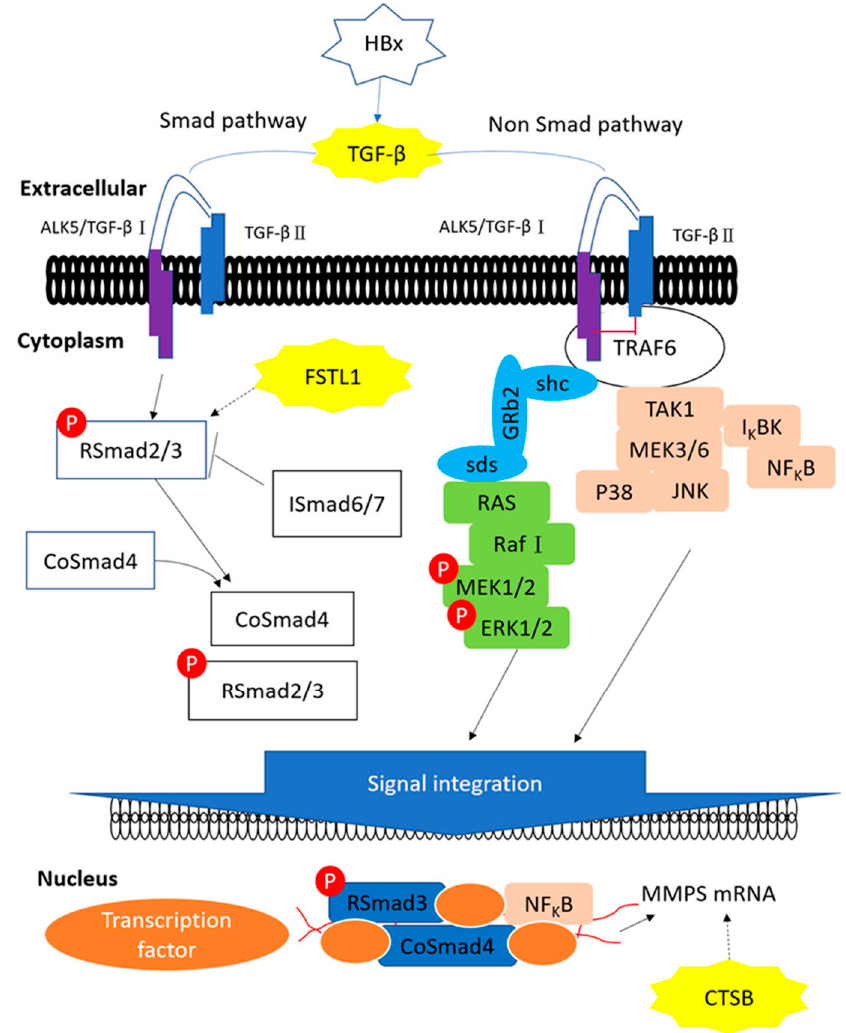
Figure 7. The proposed influences of HBx in TGF- β pathway. HBx, CTSB, TGF- β 1 and FSTL1 are heavily involved in the TGF- β signal transmission pathway. HBx induces TGF- β 1 to activate Smad and non-Smad pathways where CTSB up-regulates MMP expression and FSTL1 activates